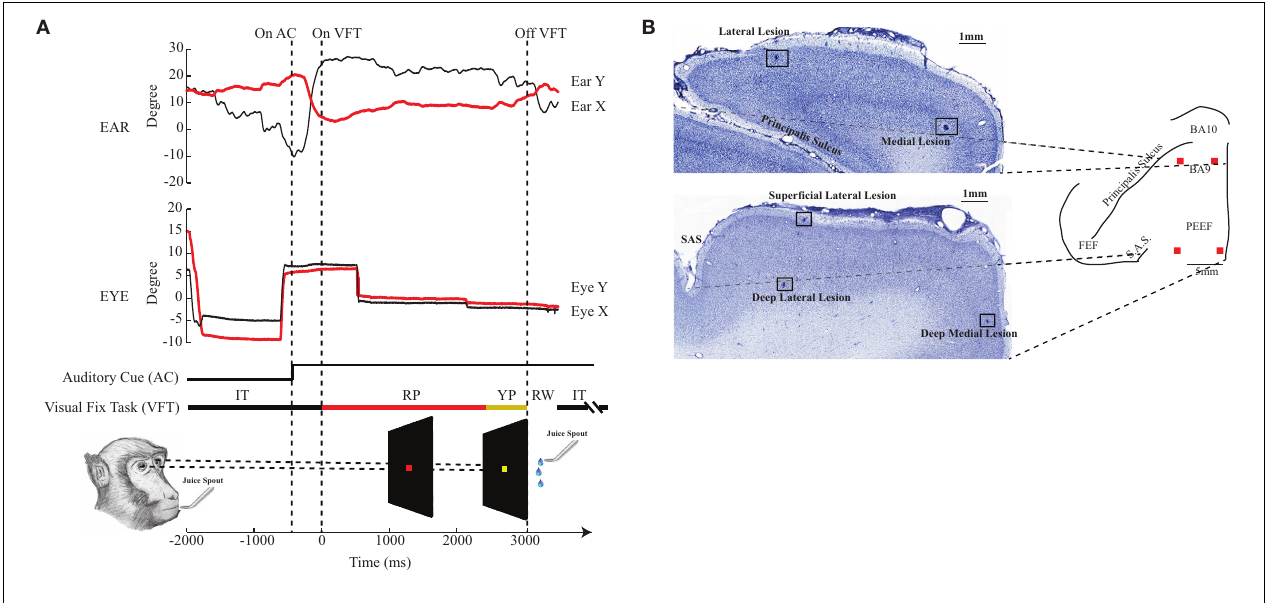
FIGURE 1 | Experimental design and histological reconstruction. (A) The bottom figure shows the paradigm of the visual fixation task (VFT). RP: red period; YP: yellow period; RW: reward; IT: intertrial. The upper and middle plots are examples respectively of the normal ear and eye behavior, outside